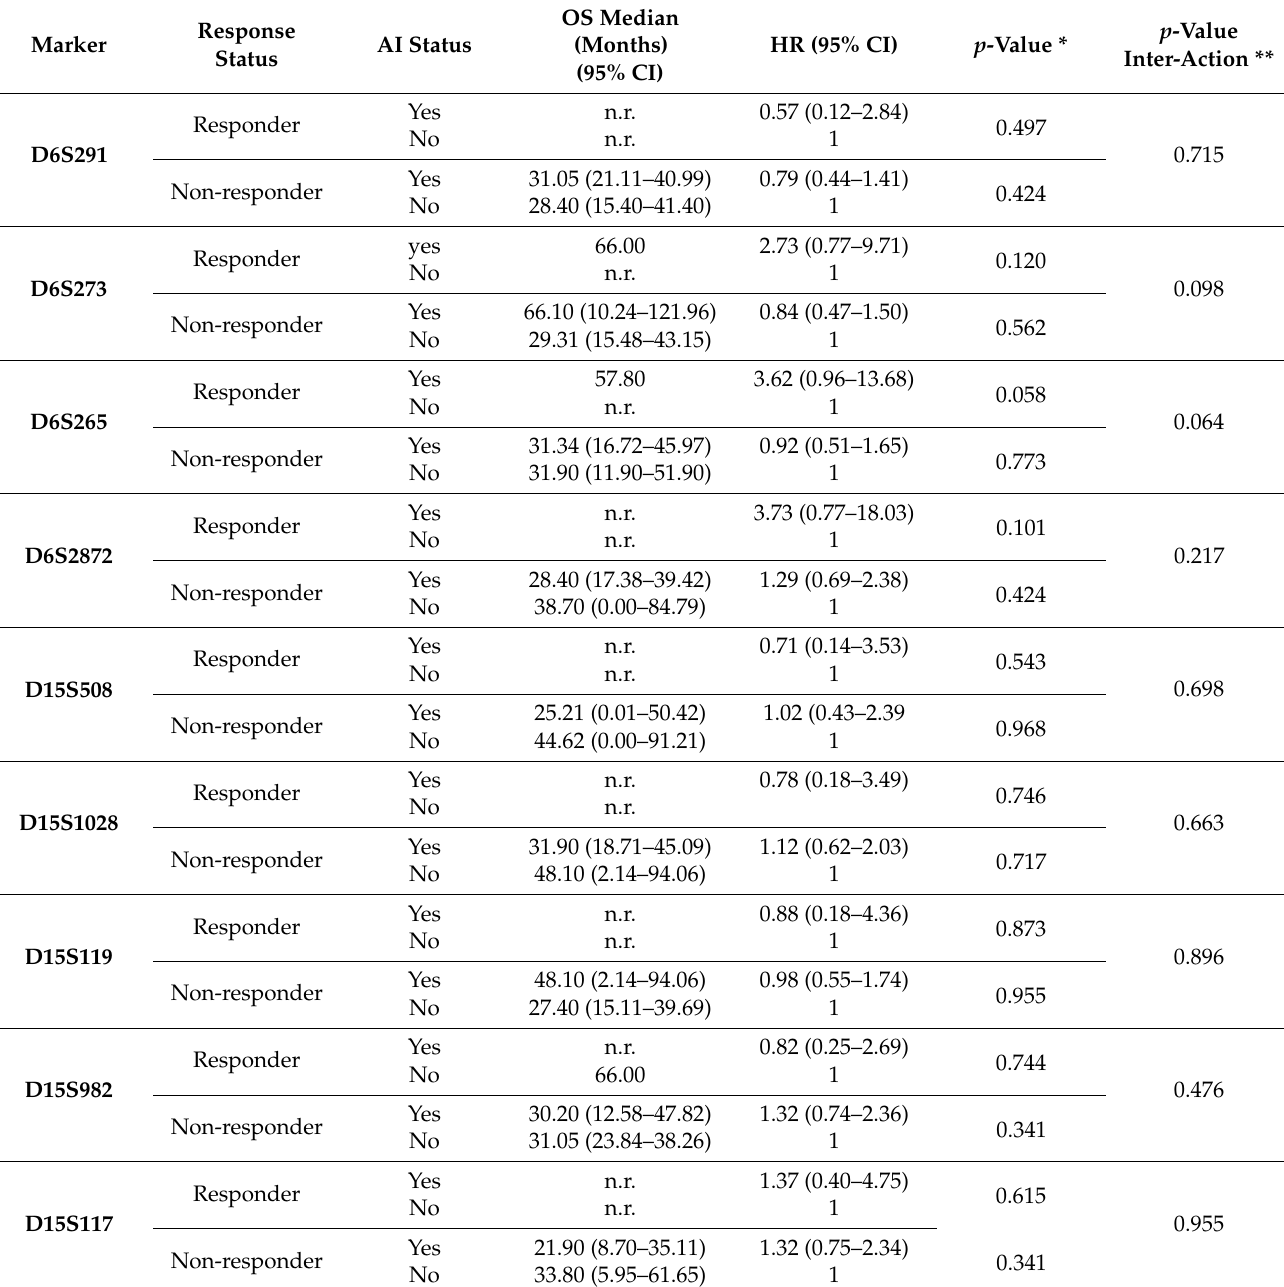
Table 4. Survival in the subgroups of the responding and non-responding patients and